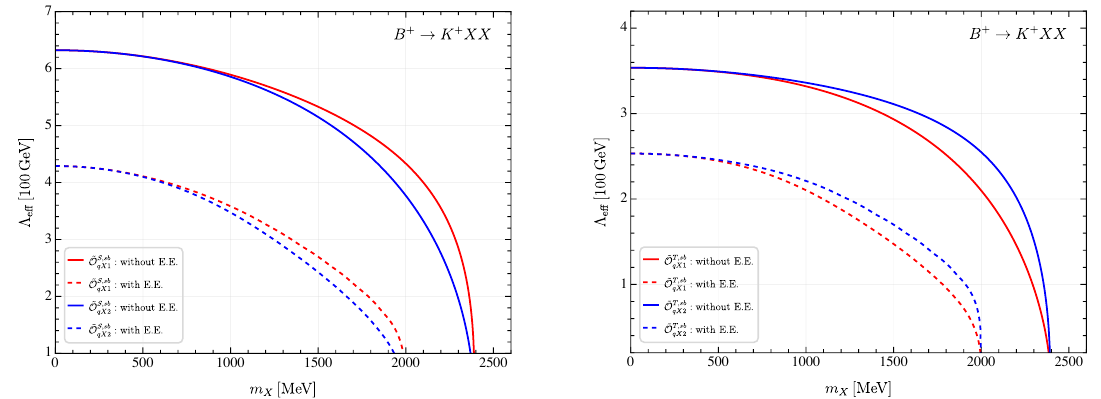
Figure 10 . Similar to figure 3 and figure 7, constraints on the effective new physics scale as a function of the DM mass m from the inclusive tag Belle II B + → K + ν ¯ ν for the vector DM of scenario